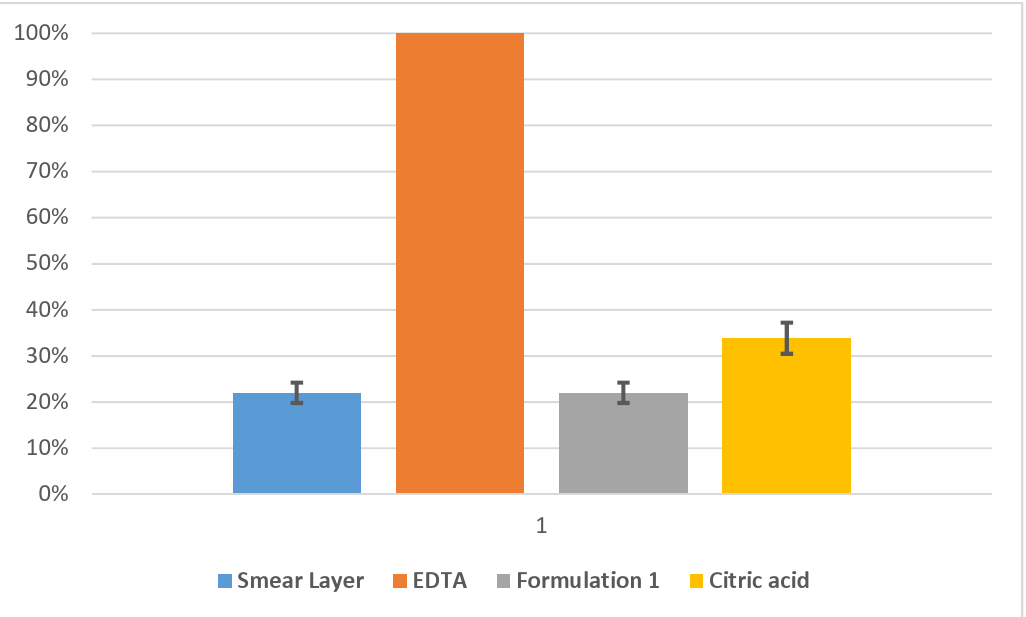
Figure 1. Normalized permeability for model dentine samples treated with formulation 1 (66% nano-apatite based cement + 20.4% PEG 1000 + 13.6% propanediol) measured after the formation of the smear layer (blue), and ethylenediaminetetraacetic acid (EDTA) (orange), formulation 1 (grey) and citric acid (yellow) treatments. Statistical variation of 20 independent measurements is reported as black bars.